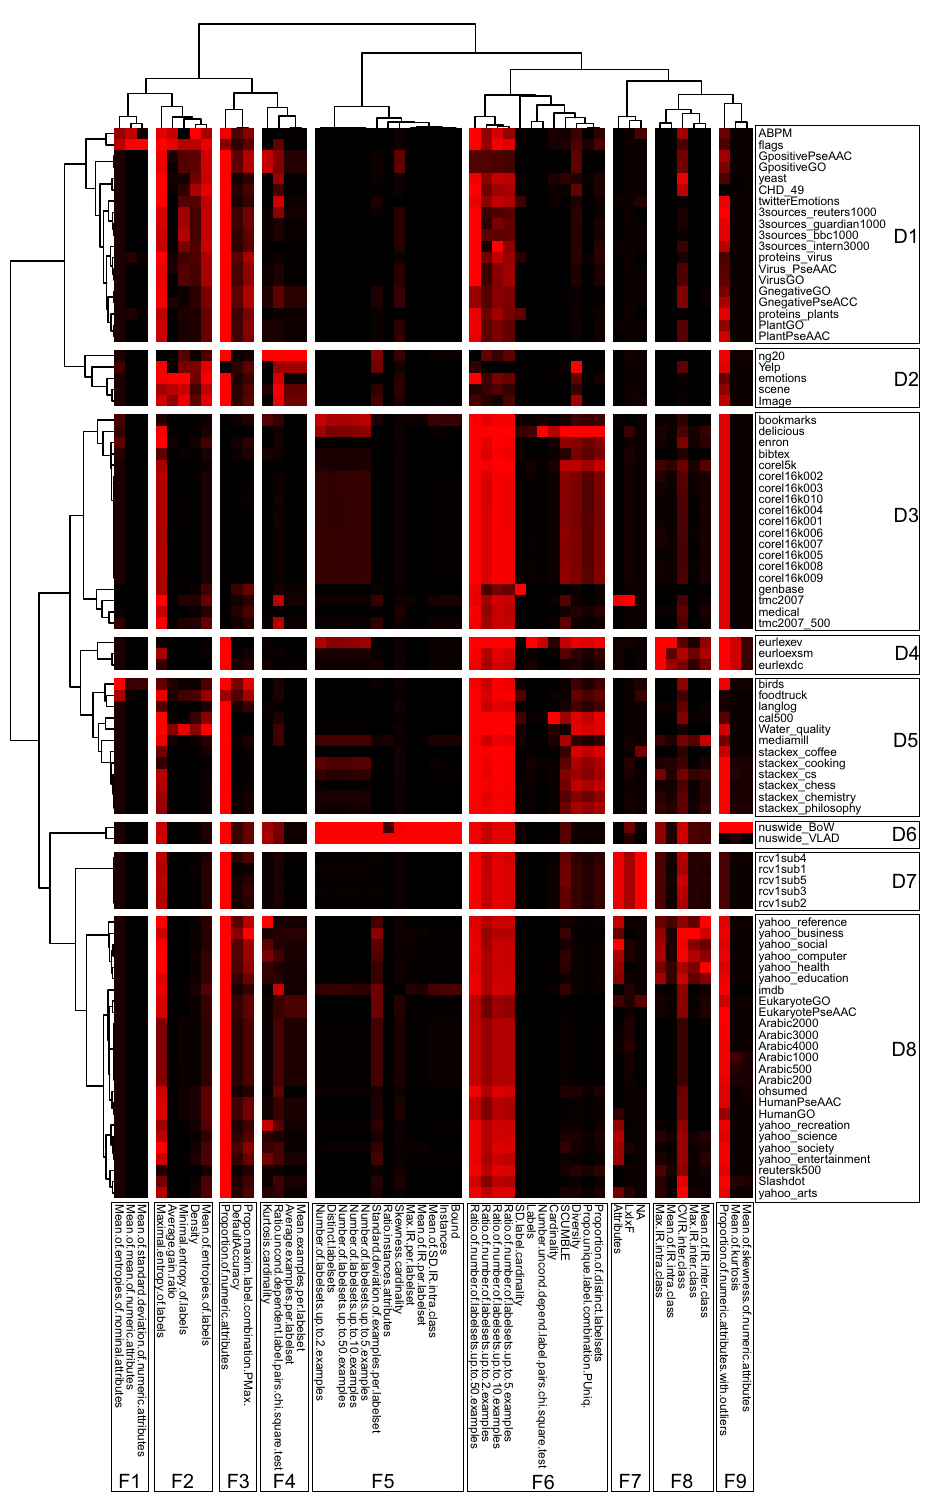
Figure 1. Heatmap of the calculated meta-features for all datasets in the catalogue. Rows represent the different datasets,while the columns represent the different meta-features. The values of meta-features are normalized to the scale 0–1 (black = 0 and red = 1). The colour of each square in the heatmap is the value of the appropriate meta-feature (column) for the appropriate dataset (row). The righthand side numbers denote dataset groups (marked with D), while bottom numbers denote meta-feature groups (marked with F). The heatmap was generated with R using the pheatmap package (version 3.6) (https:// cran.r- proje ct. org/ web/ packa ges/ pheat map/) and postprocessed by using Inkscape (https:// inksc ape. org/) version